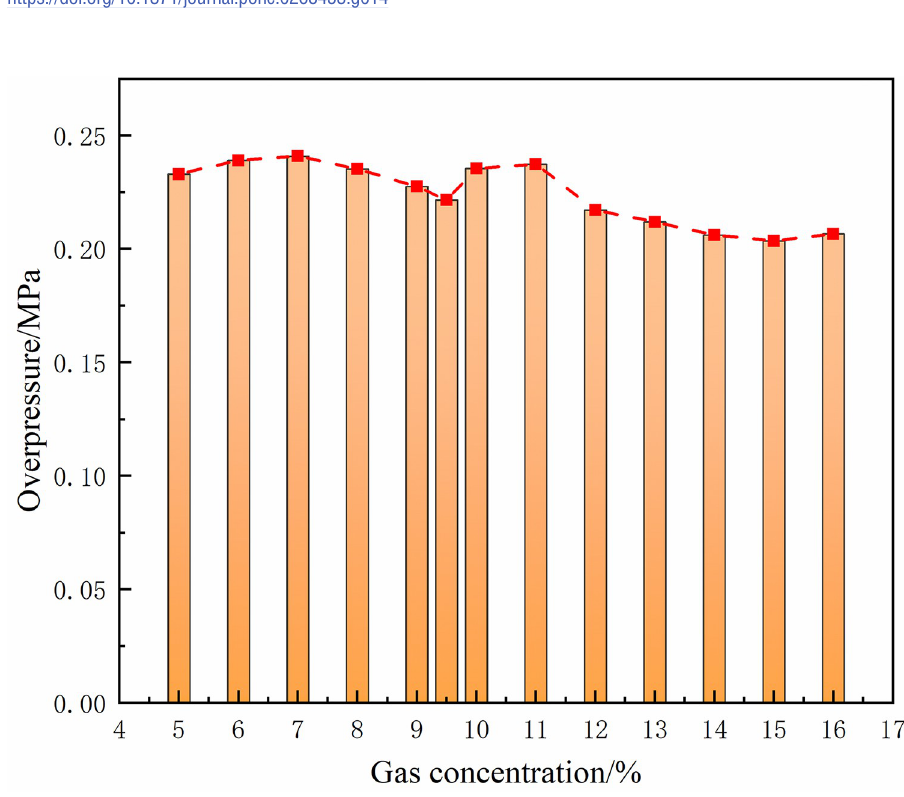
Fig 15. Pressure—Time curves and peak at monitoring point 6 at different gas concentrations (pressure peak).